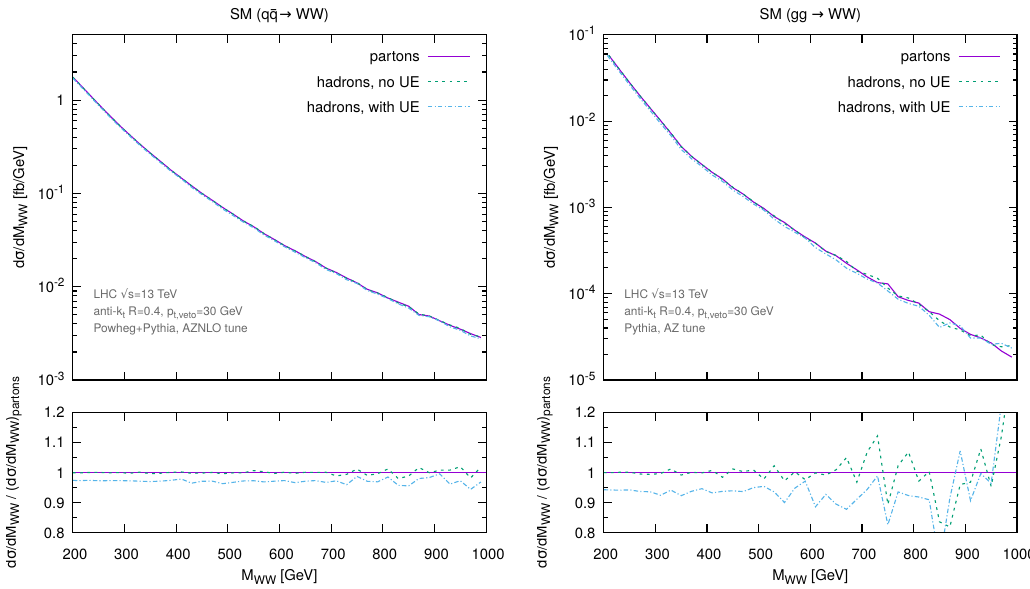
Figure 10 . Impact of hadronisation and underlying event on d(cid:27)=dM WW in the SM for q (cid:22) q (left) modelled with POWHEG+PYTHIA and gg (right) modelled with plain PYTHIA . The (cid:13)uctuations in the right plot are due to statistical uncertainties in the Monte Carlo